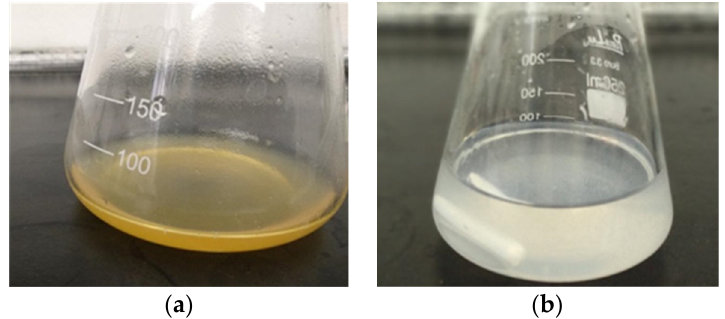
Figure 7. Precipitates obtained from the purification process at ( a ) pH 5 and ( b ) pH 9.